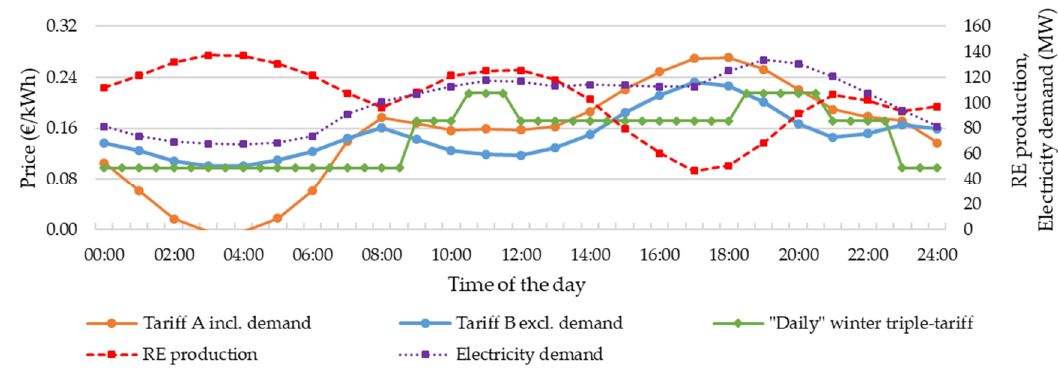
Figure 8. Proposed example of dynamic price mechanism resulting from renewable energy (RE) production including (tariff A) or excluding electricity demand (tariff B) on Madeira modeled in EnergyPLAN for 7 January .